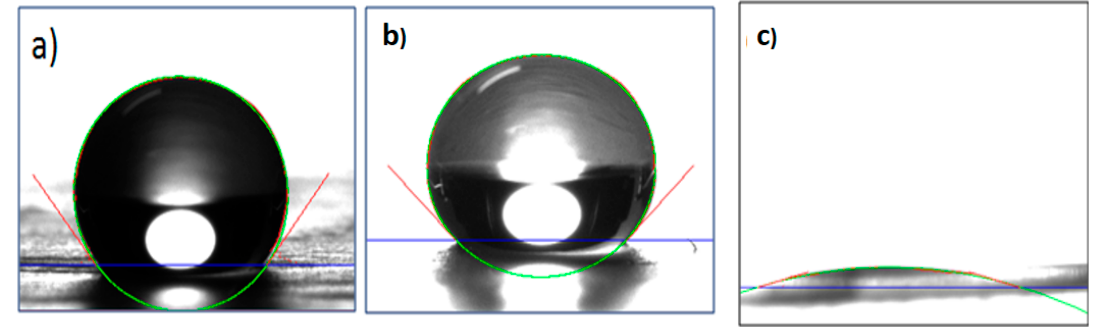
Figure 14. Water Contact Angle (CA) for nanofibers of: ( a ) PCL; ( b ) β -CD IC; and ( c ) β -CD-NH 2 IC.